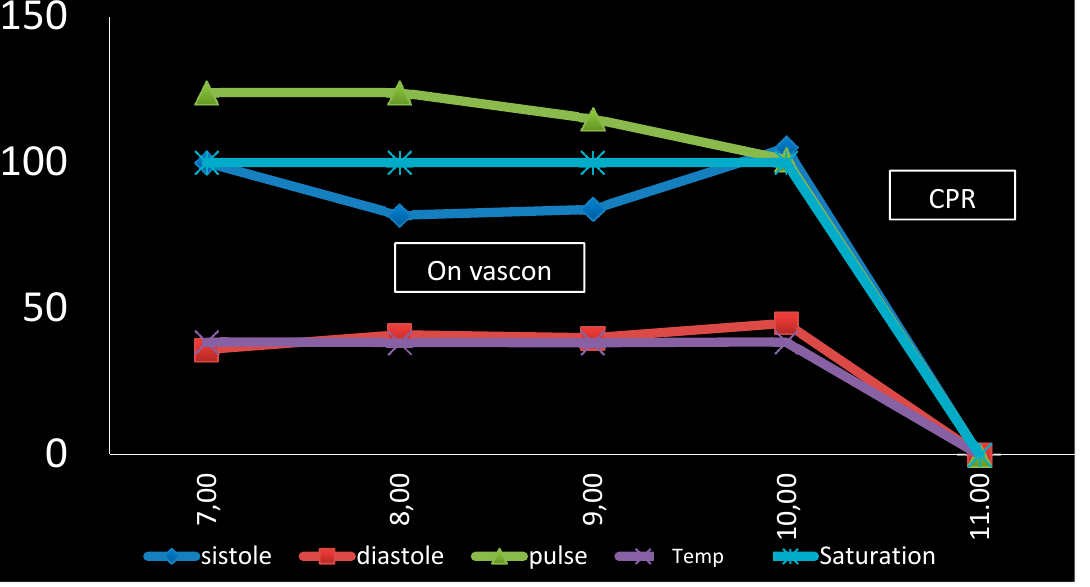
Figure 1. Vital chart of the last four hours.